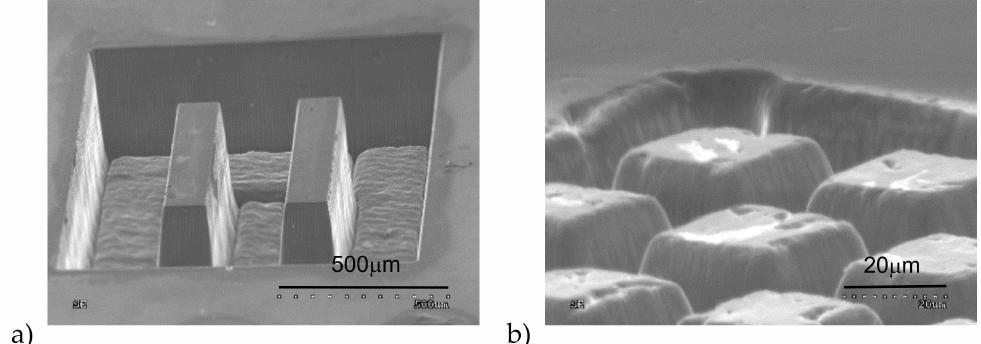
Figure 5. Examples of SEM images of di ff erent structures obtained on the surface of CVD diamond plate at laser system condition: average power—9.5 W, scanning speed—250 mm / s, hatching distance —10 and 20 µ m (image a and b,